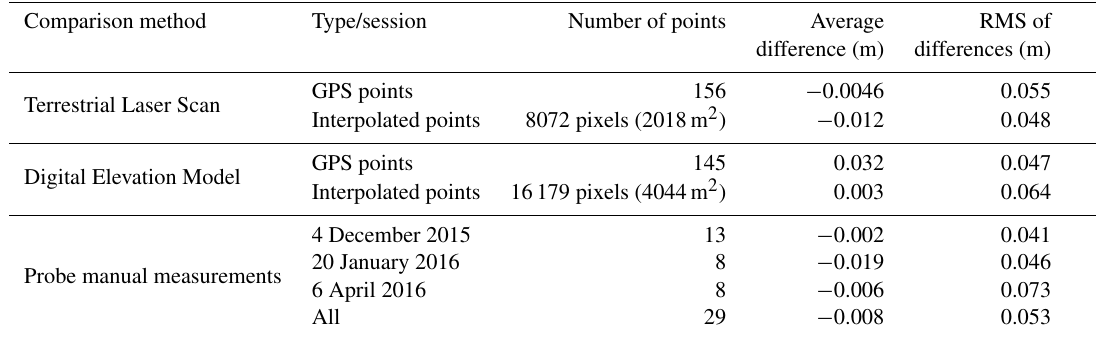
Table 2. Average difference and RMS of the differences between interpolated snow surface elevation and Terrestrial Laser Scan measure- ments on a snow pile (1 December 2015), between the elevation of bare ground with the GPS method and the existing Digital Elevation Model (DEM) and between interpolated snow depths and probe measurements on ski slopes (Appendix B).